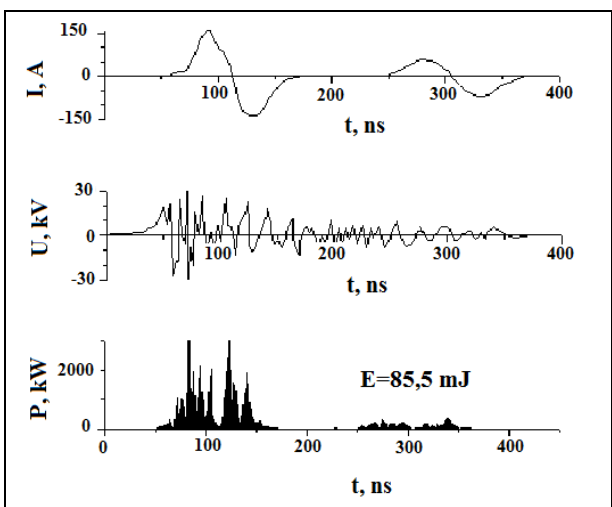
Figure 2. The dependence of the pulsed electric power of the discharge on time, oscillograms of voltage and current of a bipolar nanosecond discharge above the surface of a 5% solution of CuSO salt in distilled water at the air pressure in 4 the discharge chamber equal to 6.5